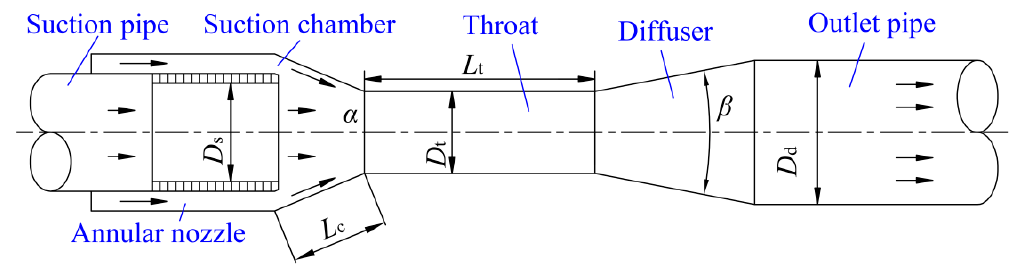
Figure 1. Early annular jet pump (EAJP).